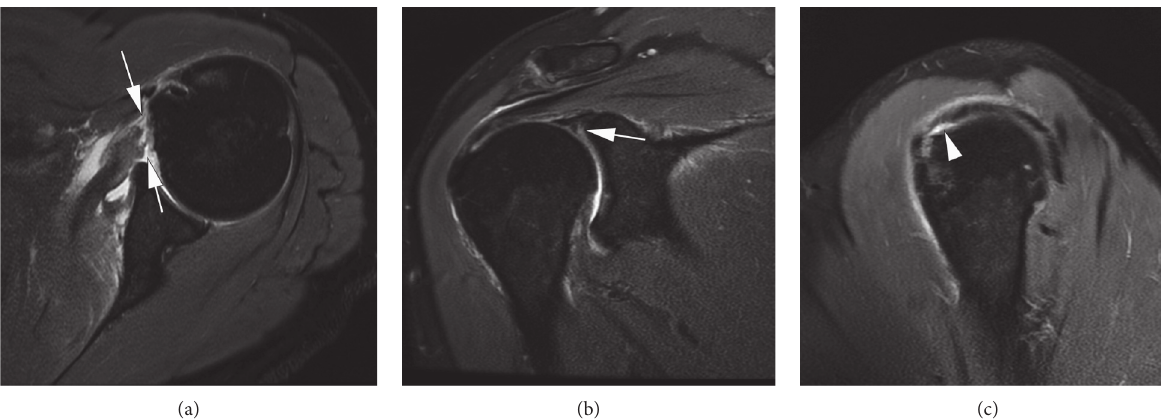
Figure 6: A 46-year-old man with left shoulder pain and limited range of motion after falling during football. Axial T2-weighted FS MRI (a) shows a full-thickness subscapularis tendon tear without relevant retraction from its attachment (arrows). In addition, there is a superior labral tear (arrow) seen on coronal T2-weighted FS MRI (b). Sagittal oblique T2-weighted FS MRI (c) demonstrates a small articular surface tear at the attachment site of the supraspinatus tendon (arrowhead).